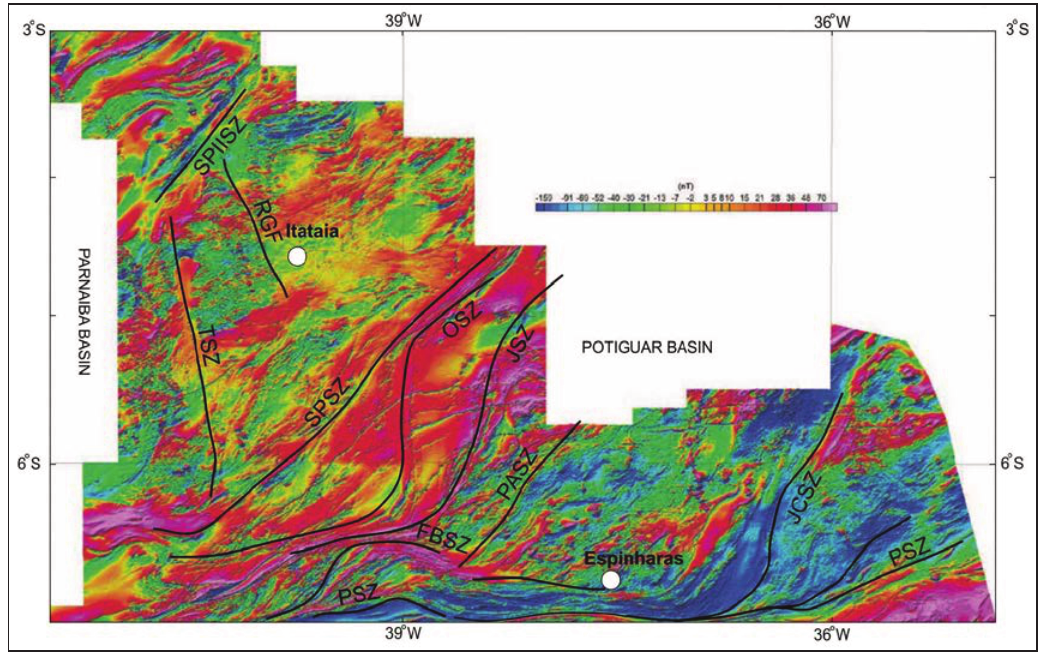
Figure 2 - Map of amplitude of the analytic signal, calculated with second order derivatives of the Northern Borborema Province, used for interpretation of the Rio Ceará-Mirim mafic dike swarm. The acronyms are the same as in Figure